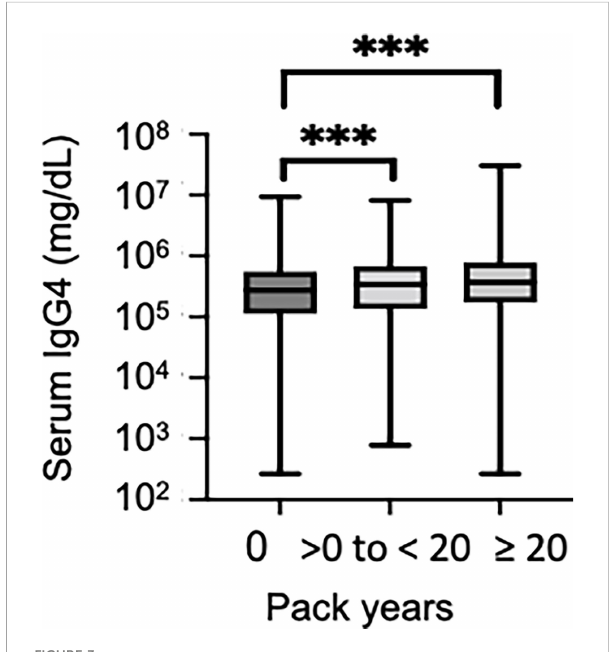
FIGURE 3 Comparison of serum IgG4 levels by smoking intensity. Serum IgG4 levels divided into the following three categories according to the smoking intensity were compared: pack-year = 0 non-smoker, 0 < pack-year < 20 light smoker, pack-year ≥ 20 heavy smoker. ***p < 0.001 with respect to the reference